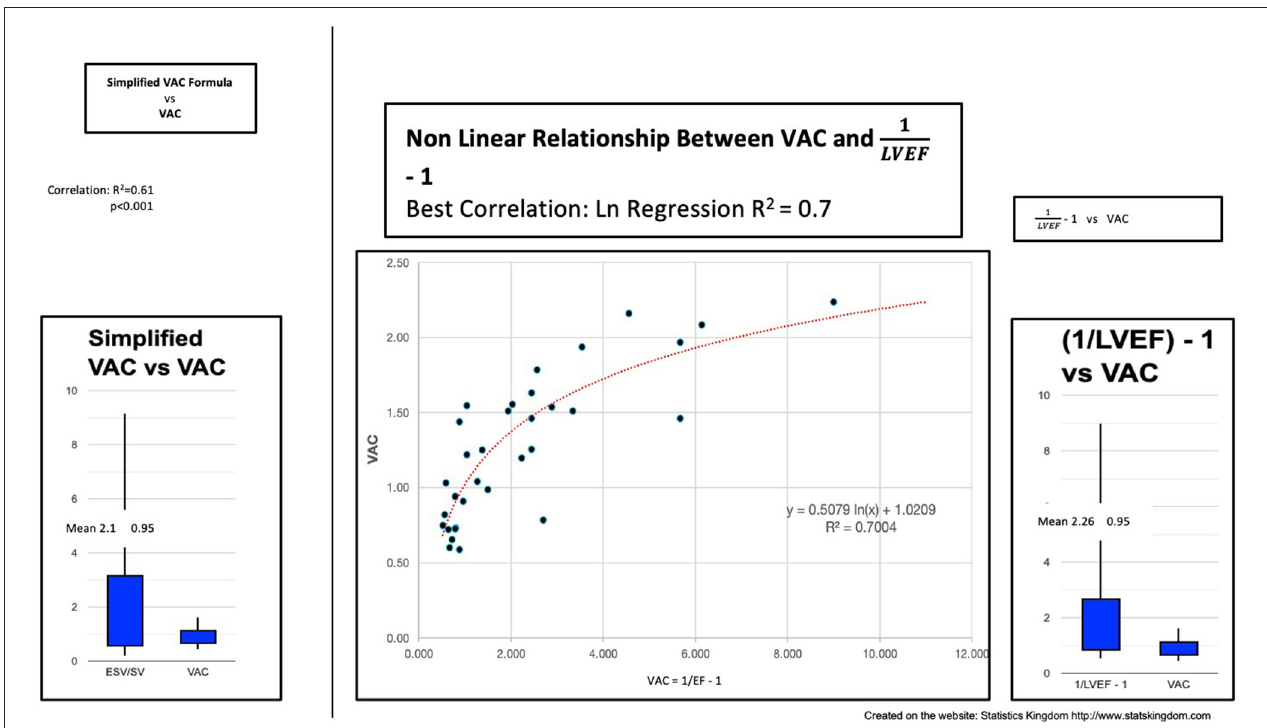
FIGURE 4 | Left : Simplified VAC (ESV/SV) vs. VAC; Center: Curvilinear (logarithmic) regression between (1/LVEF) – 1 and VAC; Right: VAC calculated by (1/LVEF) – 1 vs. VAC ESV left ventricle end-systolic volume, SV stroke volume, VAC ventricular-arterial coupling, LVEF left ventricular ejection fraction.